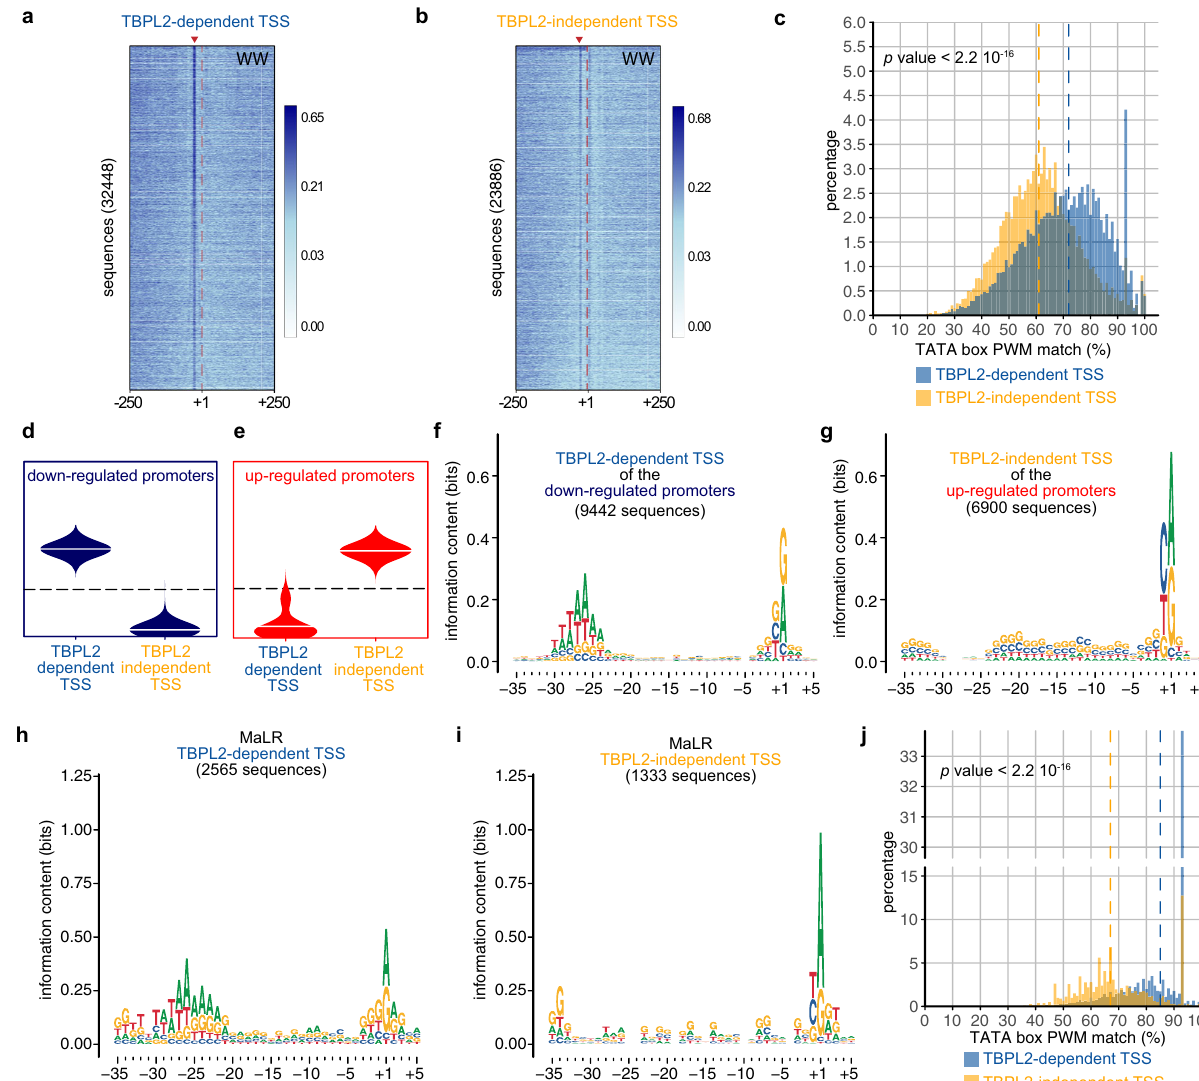
Fig. 5 Core promoter regions of TBPL2-speci fi c transcription units in postnatal day 14 oocytes are enriched in TATA-like elements and are sharp. a , b Genome-wide A/T-rich dinucleotide (WW) motif analyses of − 250/ + 250 sequences centred on the dominant transcription start sites (TSS, position + 1, dashed red line) of TBPL2-dependent ( a n = 32,448) and TBPL2-independent ( b n = 23,886) TSS clusters. Sequences have been ordered by increasing size of the interquantile width of each. The red arrowheads indicate the WW enrichment at position − 30 in the TBPL2-dependent TSS clusters ( a ) and the equivalent position in the TBPL2-independent TSS clusters ( b ). The number of TSS clusters is indicated in brackets. c Distribution of the best TATA box position weight matrix (PWM) matches within a − 35 to − 20 region upstream of the dominant TSSs ( + 1) of TBPL2-dependent (blue) compared to the TBPL2-independent (orange) TSS clusters. The dashed lines indicate the median of the TATA box PWM matches for the TBPL2-dependent (blue) and the TBPL2-independent (orange) TSS clusters ( P value after a two-tailed Wilcoxon rank-sum test). d , e Two selected self-organising map (SOM) groups of the consensus TSS clusters: the downregulated promoters (blue, d ) and the upregulated promoters (red, e ) groups. f , g Sequence logos of the − 35/ + 5 sequence of the TBPL2-dependent dominant TSSs from the downregulated promoters ( f ) and of the TBPL2-independent dominant TSSs from the upregulated promoters ( g ). h , i Sequence logo of the − 35/ + 5 sequence of the MaLR ERVs TBPL2-dependent ( h ) and TBPL2-independent ( i ) dominant TSSs. j Distribution of the best TATA box PWM matches within a − 35 to − 20 region upstream of the TBPL2-dependent (blue) and TBPL2-independent (orange) mammalian apparent LTR retrotransposons (MaLR) endogenous retroviral elements (ERV) dominant TSS. The dashed lines indicate the median of the TATA box PWM matches for the TBPL2-dependent (blue) and the TBPL2-independent (orange) TSS clusters ( P value after a two-tailed Wilcoxon rank-sum